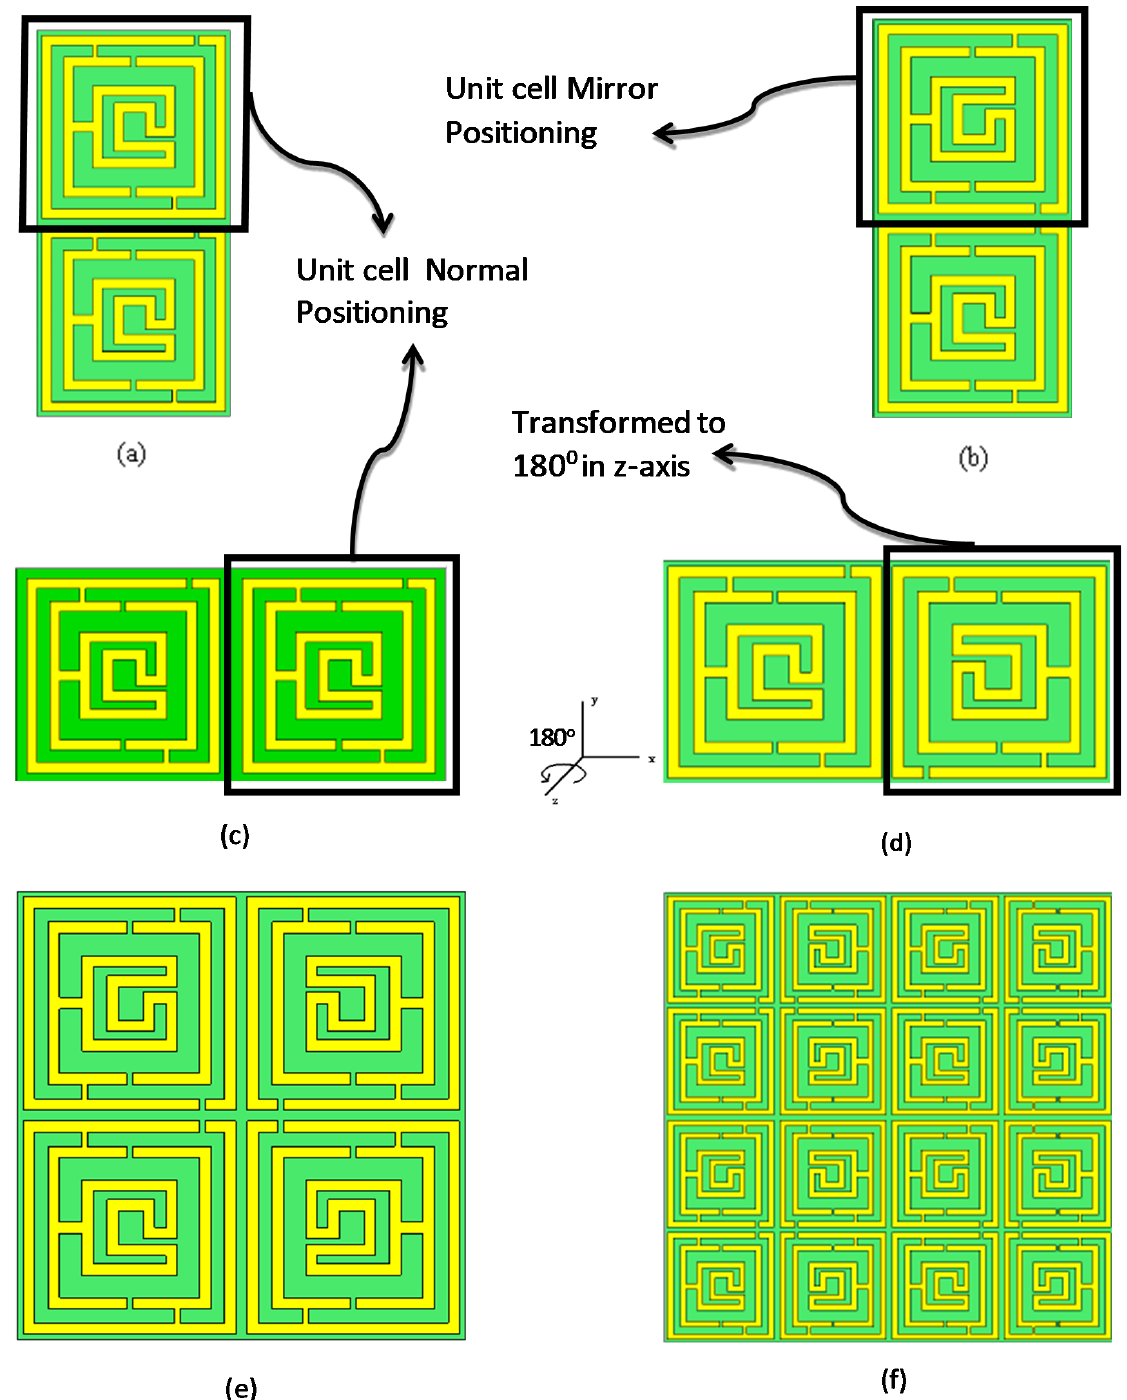
Figure 12. Metamaterial ( a ) 1 × 2 sized arrays without mirror positioning; ( b ) 1 × 2 sized array with mirror positioning; ( c ) 2 × 1 sized array with normal positioning; ( d ) 2 × 1 sized array with transform positioning; ( e ) 2 × 2 sized array with mirror positioning; ( f ) 4 × 4 sized array with mirror position- ing.